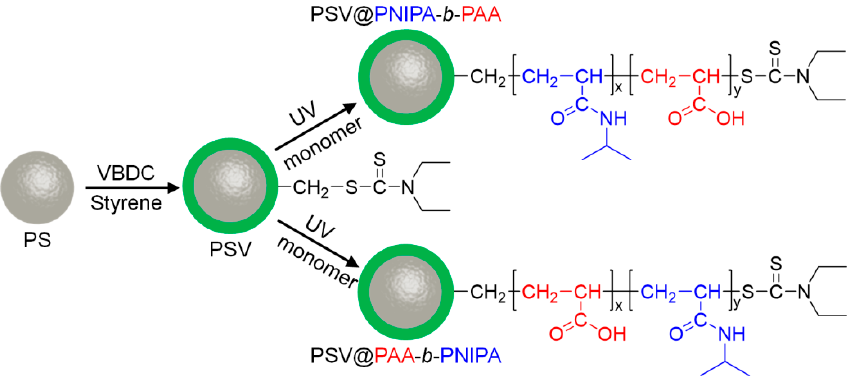
Scheme 1. Schematic representation of the synthetic process and chemical structures of diblock polymer brushes.